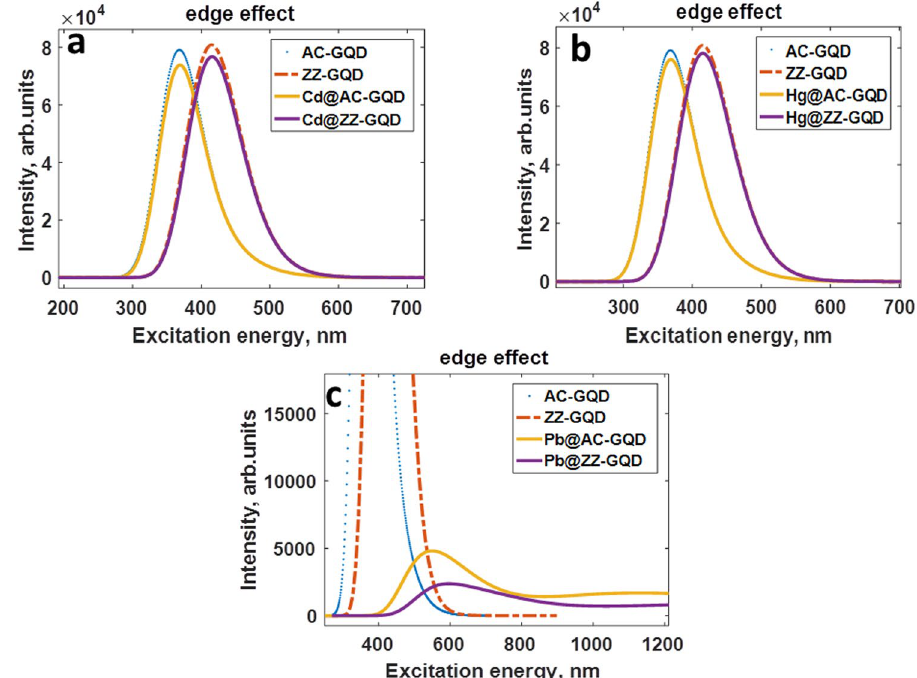
Figure 13. UV/Vis absorption spectra of the zigzag-edged and armchair GQDs before and after complexation with neutral heavy metal adatoms, namely ( a ) Cd, ( b ) Hg and ( c )